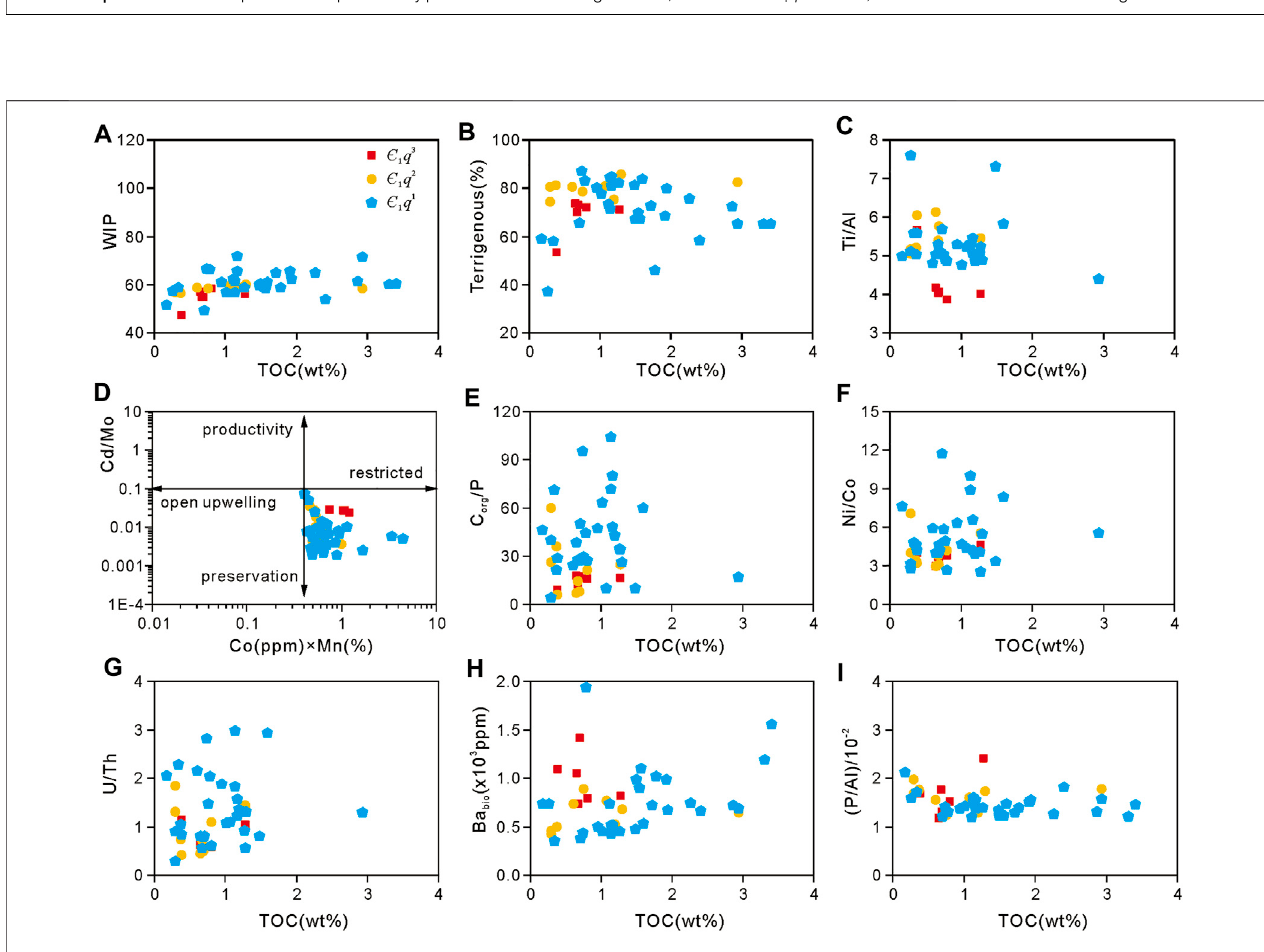
FIGURE 9 | Cross-plots indicating the organic matter enrichment mechanism of the Early Cambrian Qiongzhusi Fm, W207 Well, SW Sichuan Basin. (A-B) paleoweathering and terrigenous detrital index vs. TOC (organic matter enrichment). (C-D) hydrodynamic index vs. TOC. (E-G) redox index vs. TOC. (H-I) paleoproductivity index vs. TOC. WIP: weathering index of Parker (Parker, 1970); Terrigenous: Ti content of sediments; Babio: biogenic Ba; TOC: total organic carbon; Є 1 ’ 2,3 : fi rst, second and third member of Qiongzhusi Fm. 1 q